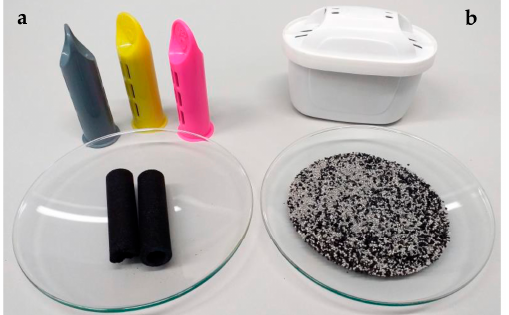
Figure 1. Exhausted filter cartridges: ( a ) bottle filter and ( b ) jug filter.